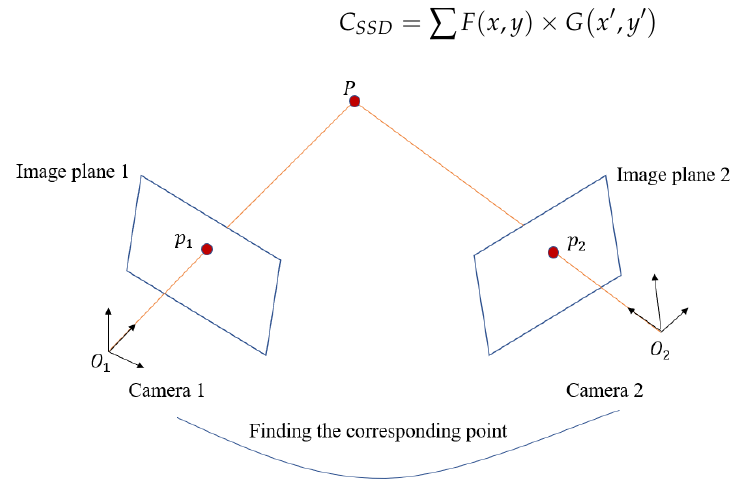
Figure 1. Schematic of stereo-vision system.